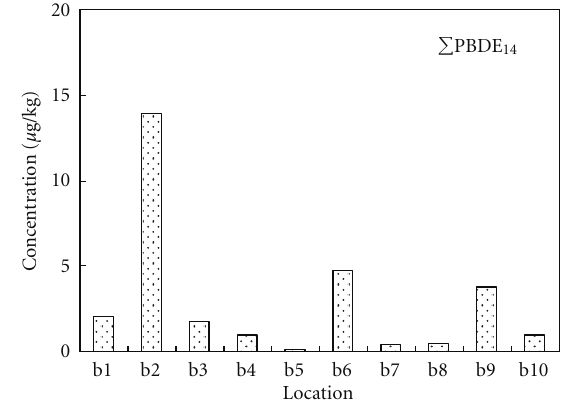
F 3: Concentrations of total OCPs in the studied sediments.